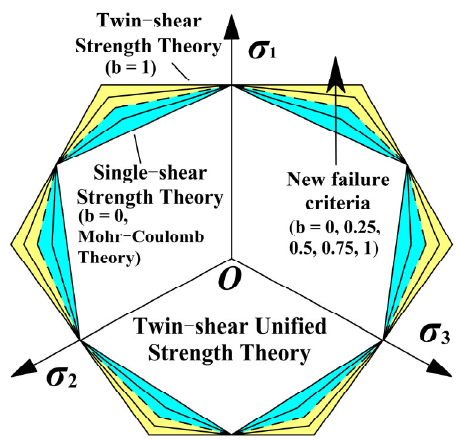
Figure 1. Yield loci of the unified strength theory.